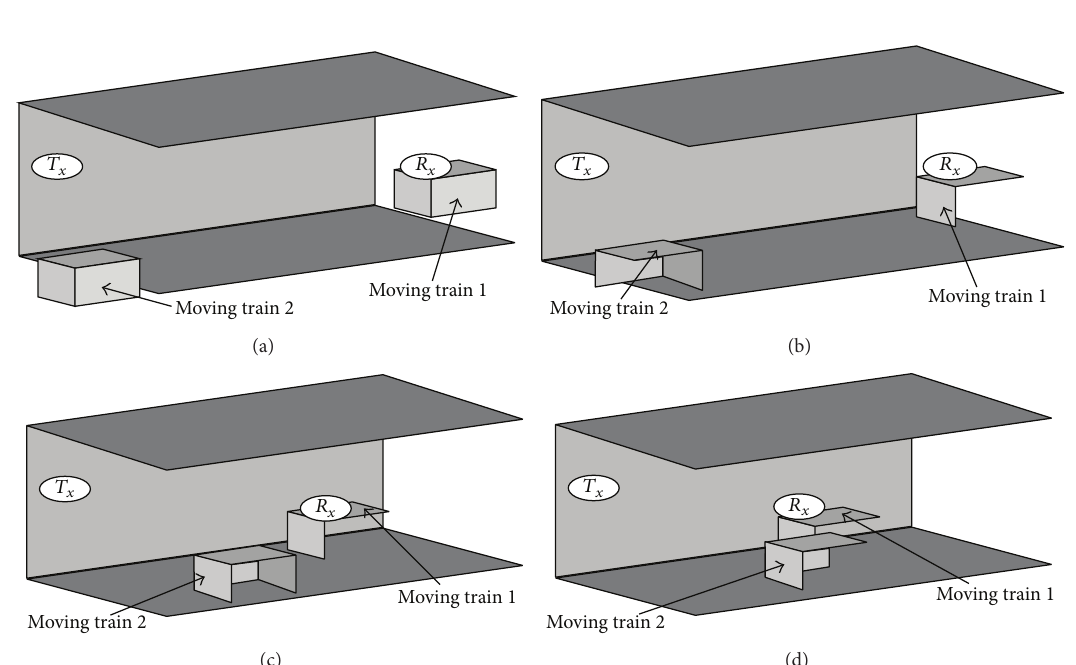
Figure 8: Description of a complex scenario.